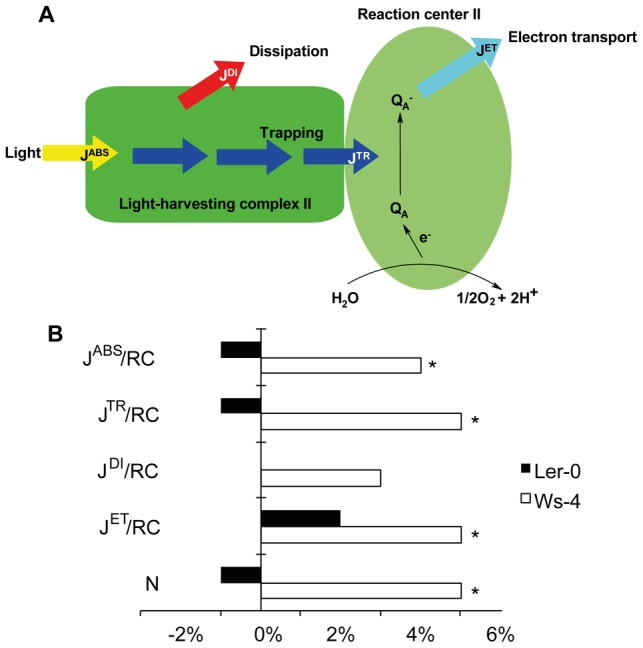
J fluxes per reaction center in Col-0, Ws-4 and Ler-0 accessions.(A) A highly simplified model of the various types of J fluxes per reaction center of photosystem II (RCII). JABS is the total photon flux absorbed by the RCII. JDI is the flux of energy that is dissipated in the light-harvesting complex II as heat and/or fluorescence. JTR is the flux of energy used for trapping in the RCII. JET is the electron flux between the two photosystems. (B) Plot of J fluxes per RC. N is the number of electrons in the transport chain. The J fluxes per RC were calculated, the values obtained were subtracted from those obtained for Col-0, and then expressed relatively to Col-0. Asterisks indicate significant difference at P<0.05 (Student's t-test, n = 20–25).